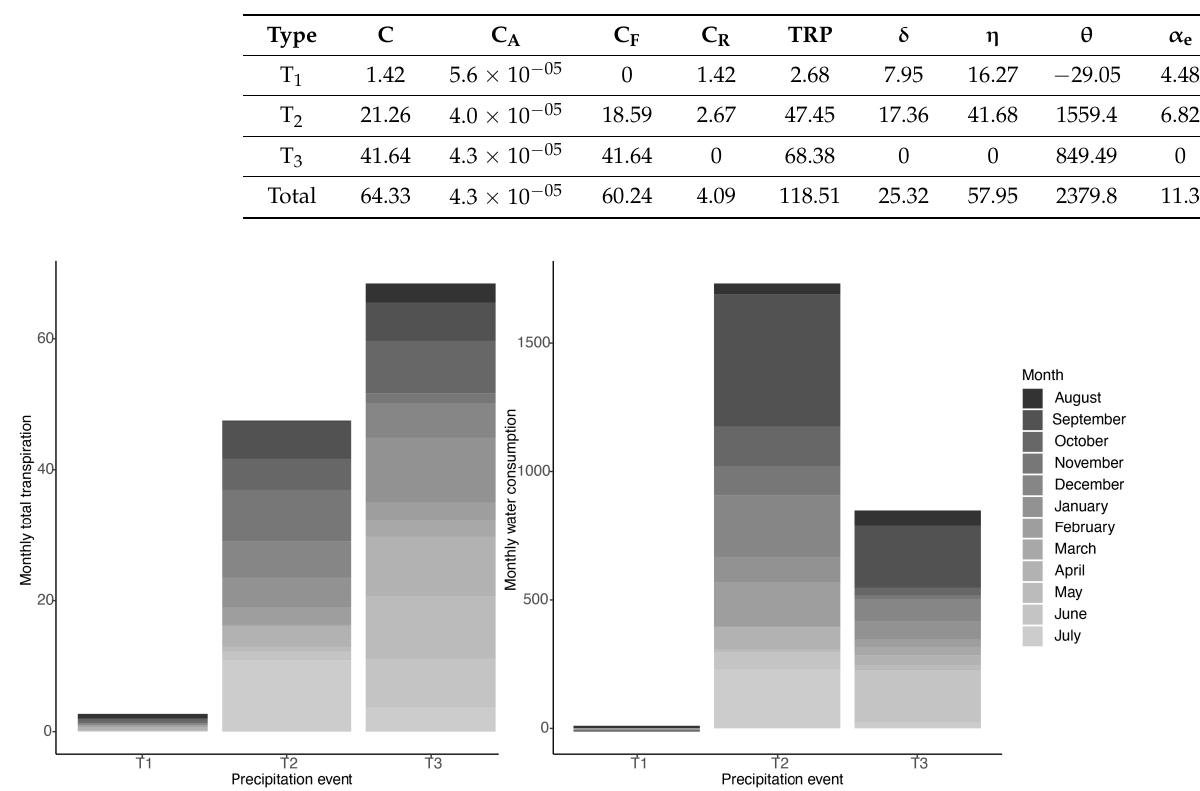
Figure 3. Monthly values of total transpiration (TRP) and water consumption (W C ). Data are given in mm according to the type of precipitation event (T 1 , T 2 , and T 3 ; see details in Materials and Methods).